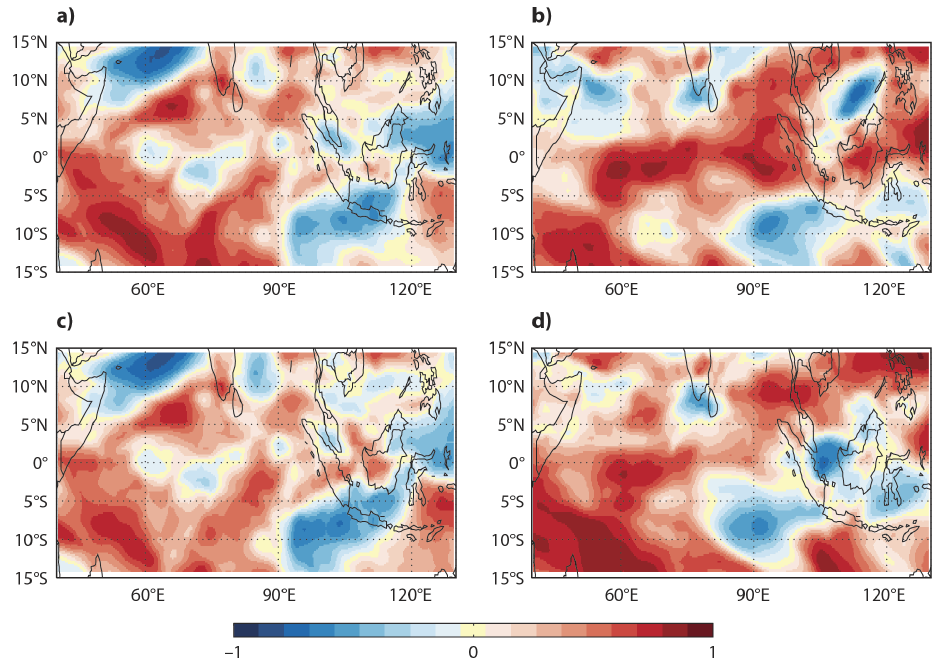
Figure 18. October O 3 –CO correlations calculated for free tropospheric (approx. 750–350hPa) column abundances over the Maritime Continent from the BASE (top) and CLIM (bottom) experiments for 2005 (left) and 2006 (right). Red colours indicated positive correlations and blue colours negative